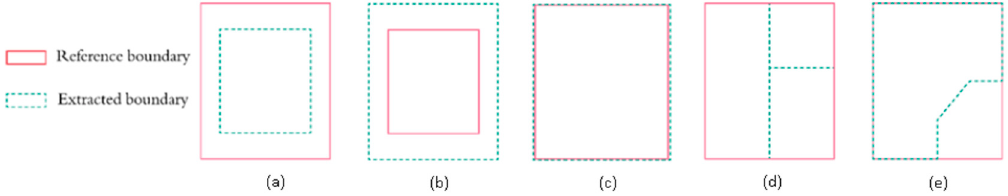
Figure 3. Geometric error scenarios: ( a ) over segmentation; ( b ) under segmentation; ( c ) edge error; ( d ) fragmentation error and ( e ) shape error.